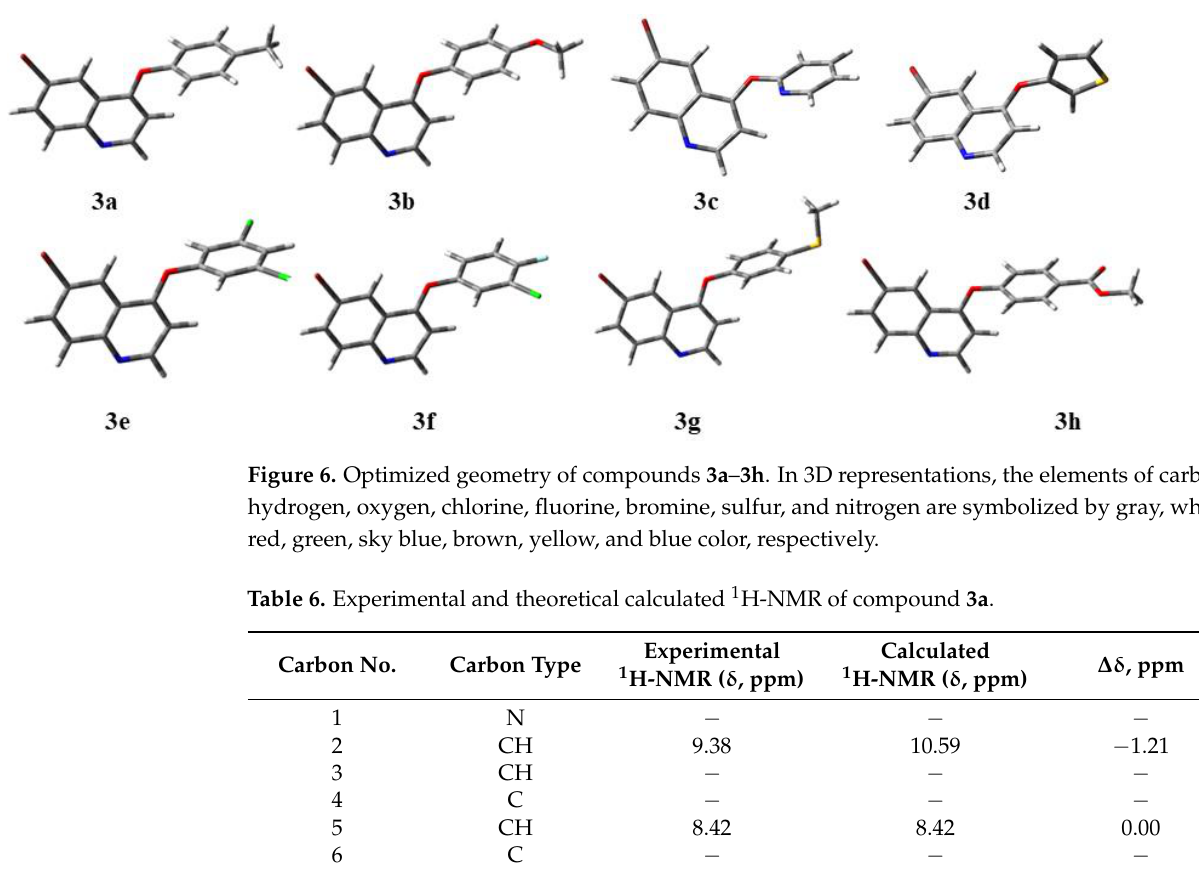
Table 6. Experimental and theoretical calculated 1 H-NMR of compound 3a . Carbon No. Carbon Type